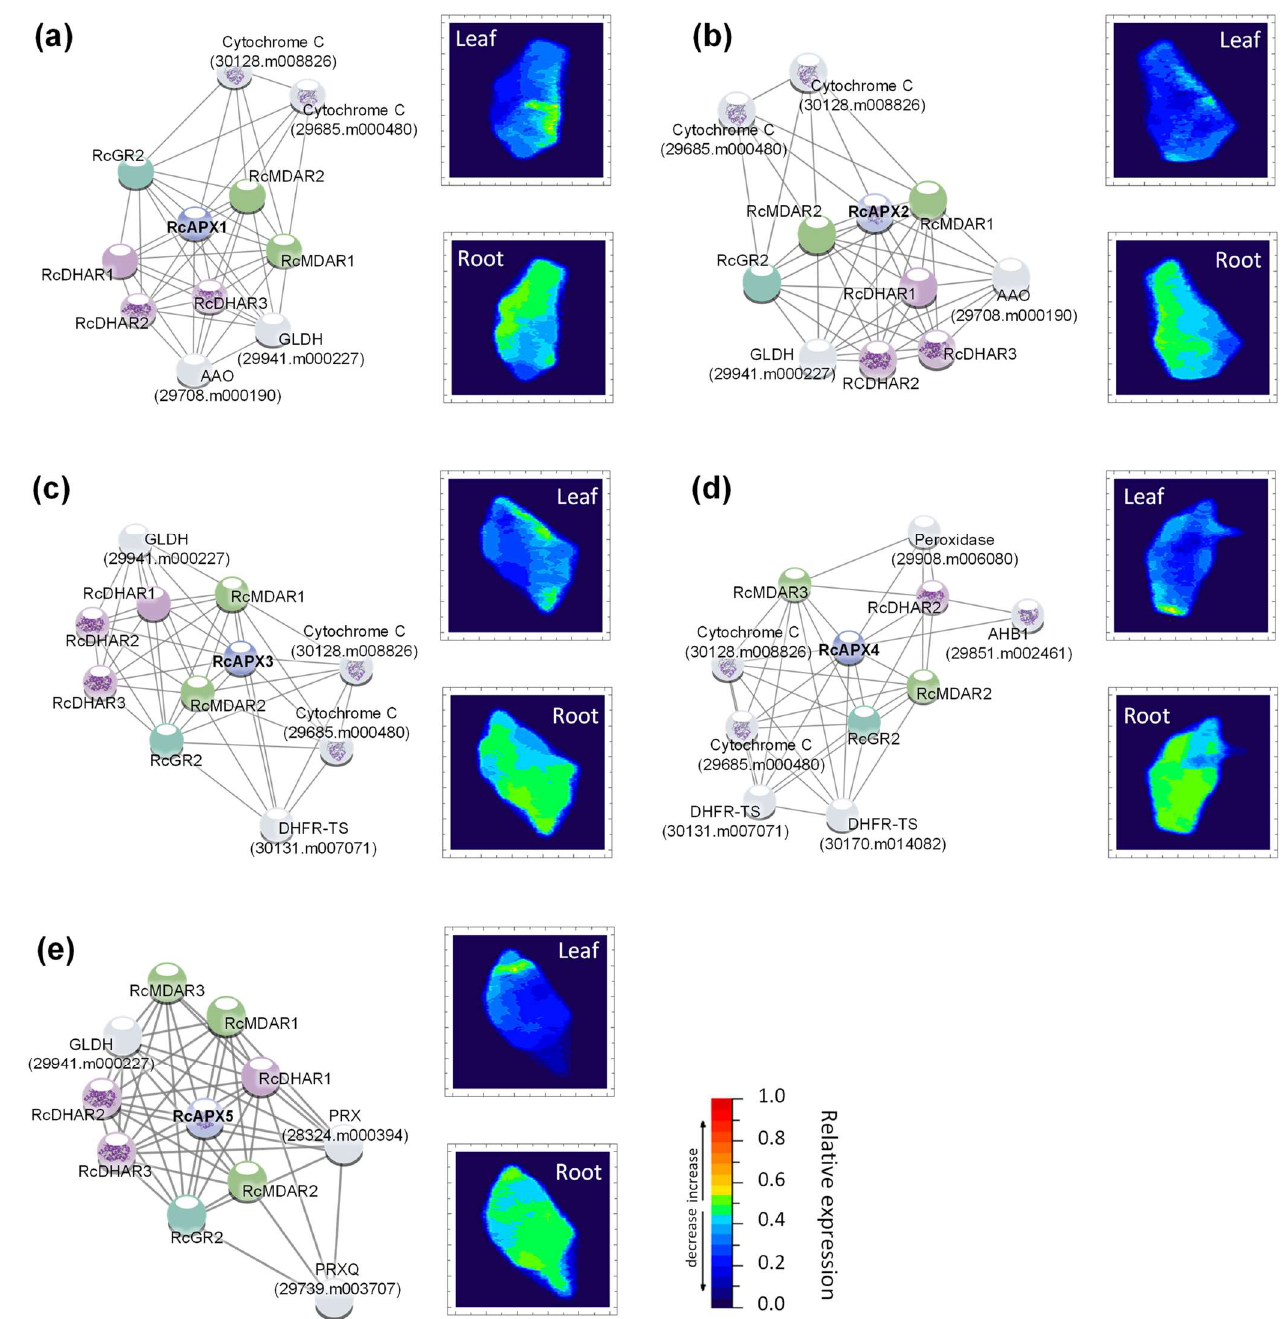
Figure 7. Predicted interaction partners of castor bean APX proteins. ( a ) RcAPX1, ( b ) RcAPX2, ( c ) RcAPX3, ( d ) RcAPX4, ( e ) RcAPX5. The heat maps demonstrate gene expression in response to drought in leaf (up) and root (down). The color scale at each heat map varies from dark blue to red representing the scale of the relative expression levels to control. AAO (Ascorbate oxidase); AHB1(Non-symbiotic hemoglobin); DHAR (Dehydroascorbate reductase); DHFR-TS (Bifunctional dihydrofolate reductase-thymidylate synthase); FBP (Fructose bisphosphatase); GLDH (L-galactono-1,4-lactone Dehydrogenase); GR (Glutathione reductase); MBF1B (Multiprotein-bridging factor 1b); MDAR (Monodehydroascorbate reductase); OCP (Overexpressor of cationic peroxidase); PPIA (peptidylprolyl isomerase); PRX (Peroxiredoxin); PRXQ (Peroxiredoxin Q).